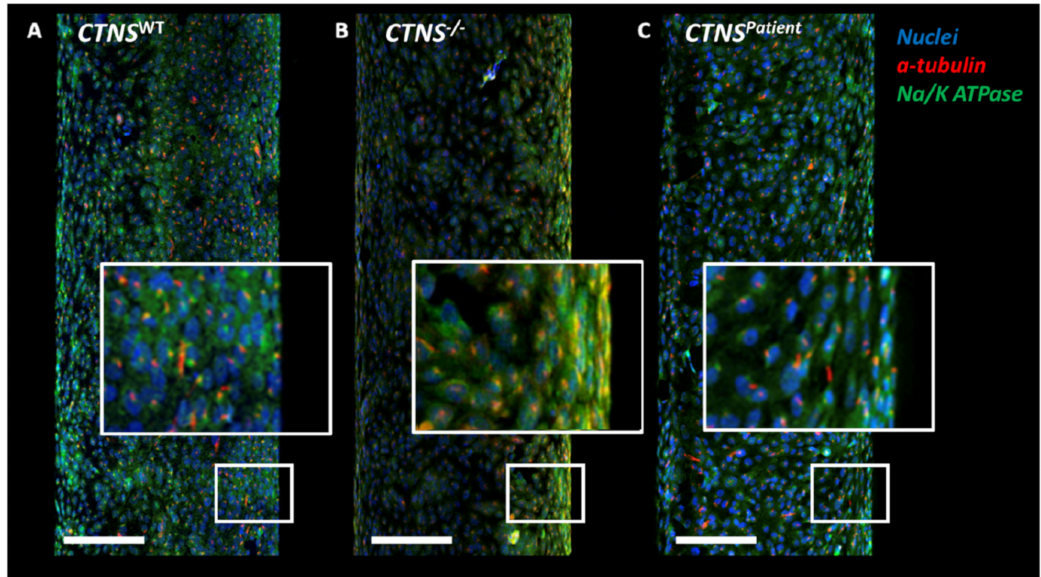
Figure 1. Confocal images of healthy and cystinotic ciPTECs kidney tubules. After maturation of 7 days, the control ciPTEC ( A ) form an organized 3-dimensional structure including primary cilia. Both cystinotic kidney tubule models ( B , C ) show visible holes in the monolayer when compared to the healthy proximal tubule model ( A ). The close-up images represent a 3-fold zoom increase. In blue: DAPI (nuclei staining), in red: α -tubulin staining, in green: Na + /K + -ATPase. Scale bar: 100 µ